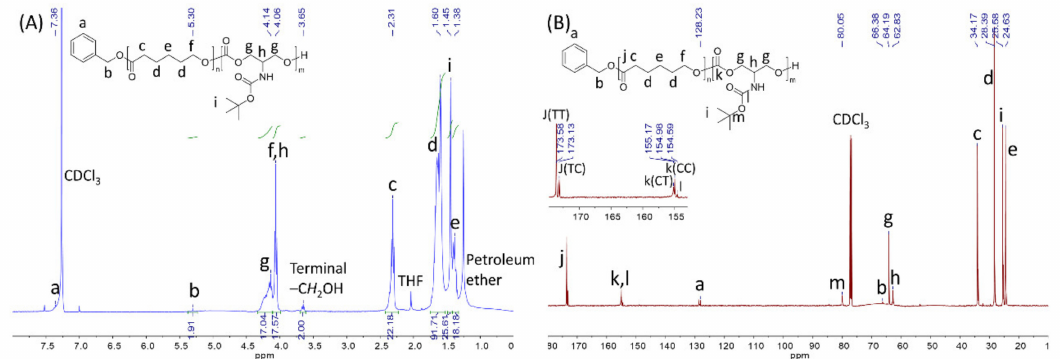
Figure 1. ( A ) 1 H NMR spectrum of P(CL- ran -TBODC 22.8%) (400 MHz, CDCl 3 , 25 ◦ C); ( B ) 13 C NMR spectrum of P(CL- ran -TBODC 22.8%). Signals labeled TT, TC, CT, CC correspond to TBODC-TBODC, TBODC-CL, CL-TBODC, and CL-CL dyads (100 MHz, CDCl 3 , 25 ◦